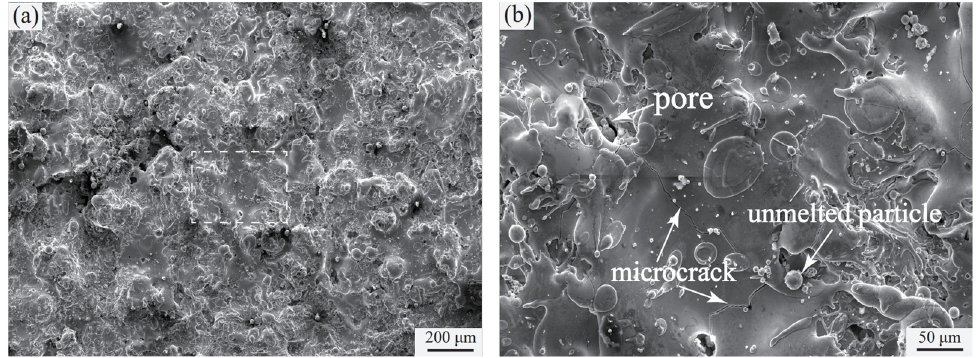
Figure 3. Surface morphology of coating ( a ) magnification of 200×; ( b ) magnification of 500×.